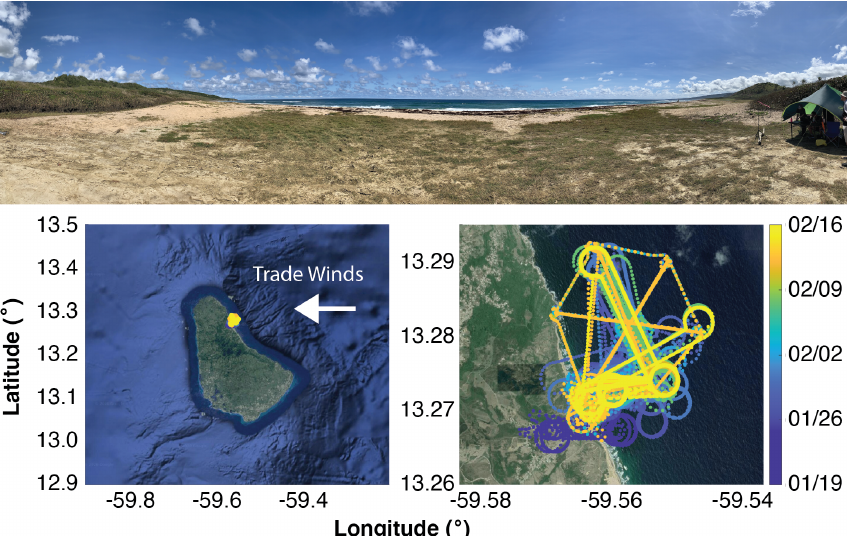
Figure 2. Morgan Lewis Beach (top) as seen from our operations site. A map of Barbados, showing the location of RAAVEN flights, relative to the rest of the island (bottom left). Details on the flight tracks completed, color-coded by date (bottom right). Background maps are ©Google Maps 2021, downloaded through their API.